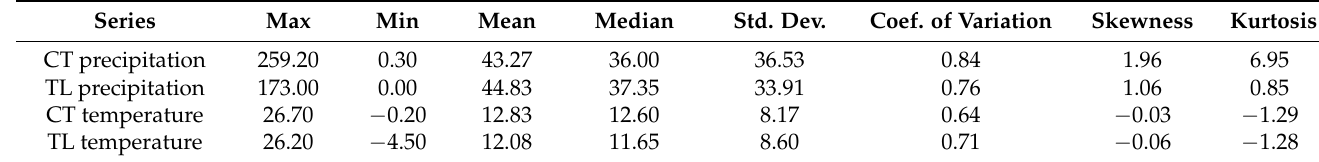
Table 1. Basic statistics of the CT and TL monthly series used for exemplification.